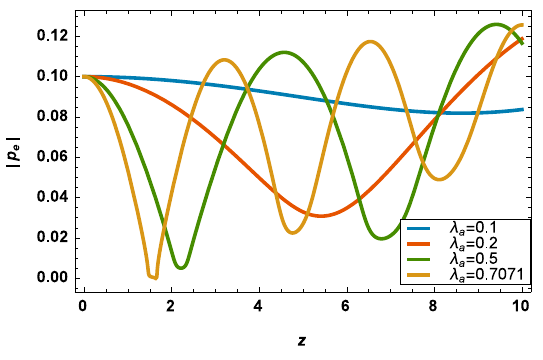
Fig. 2 Pressure along Tapered Tube for Various Values of λ a with α = 20 , β = 0 . 5